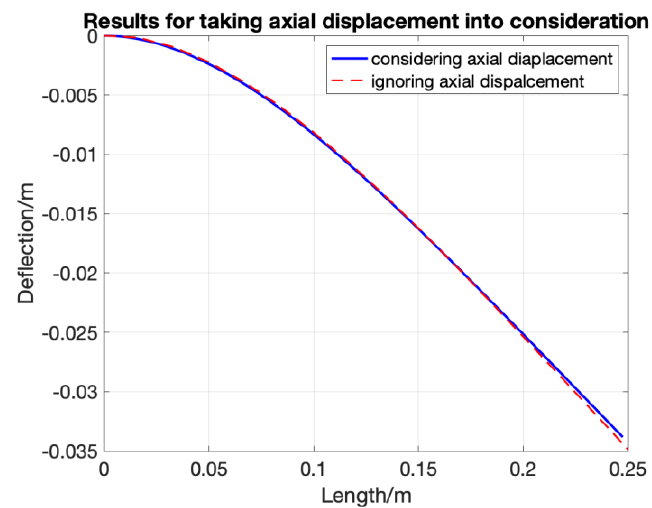
Figure 18. Comparison between different spatial resolutions in modified SDEM.